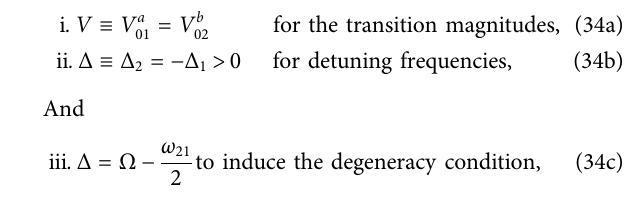
(cid:2) 0 . 10 eV as the energy difference between S 4 S 3 (cid:2) 8 . 2eV and E (cid:2) 8 . 3eVas the vertical transition energies. The angular momentum matrix S 3 S 4